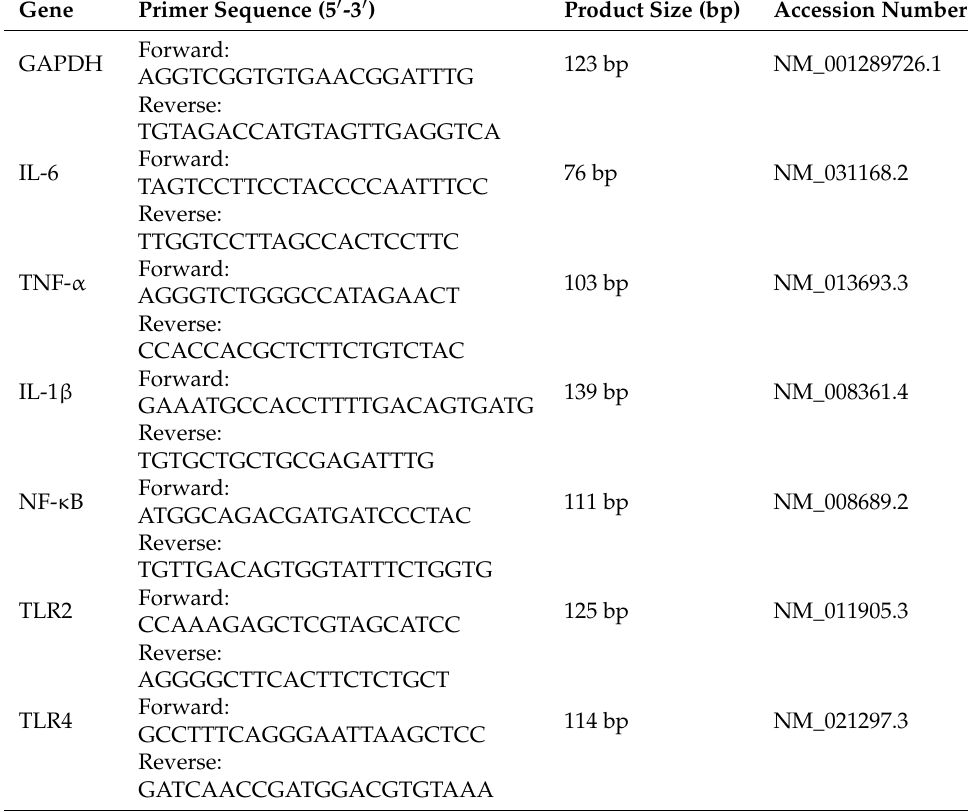
Table 1. The primers used in this